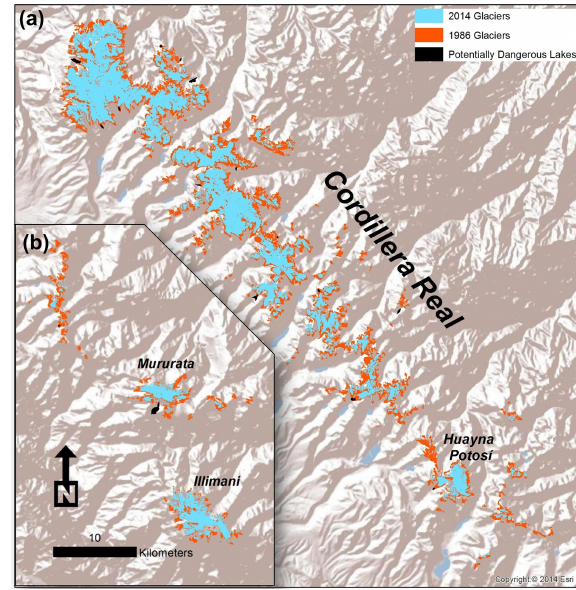
Figure 4. Glacier change 1986–2014 for the Cordillera Apolobamba. See Fig. 1 for location of region. Base map is the Esri World Shaded Relief map (2014).